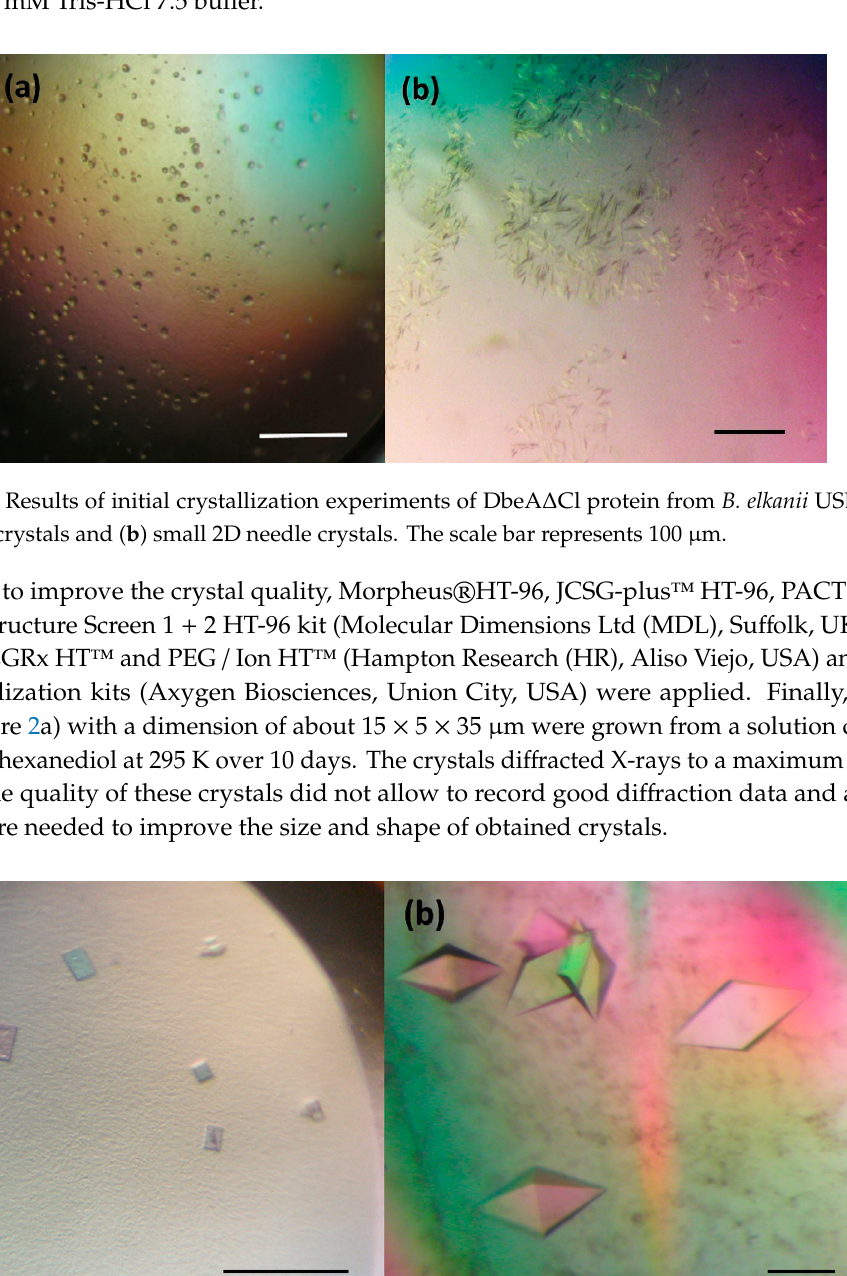
Figure 1. Results of initial crystallization experiments of DbeA Δ Cl protein from B. elkanii USDA94: (a) microcrystals and (b) small 2D needle crystals. The scale bar represents 100 µm.